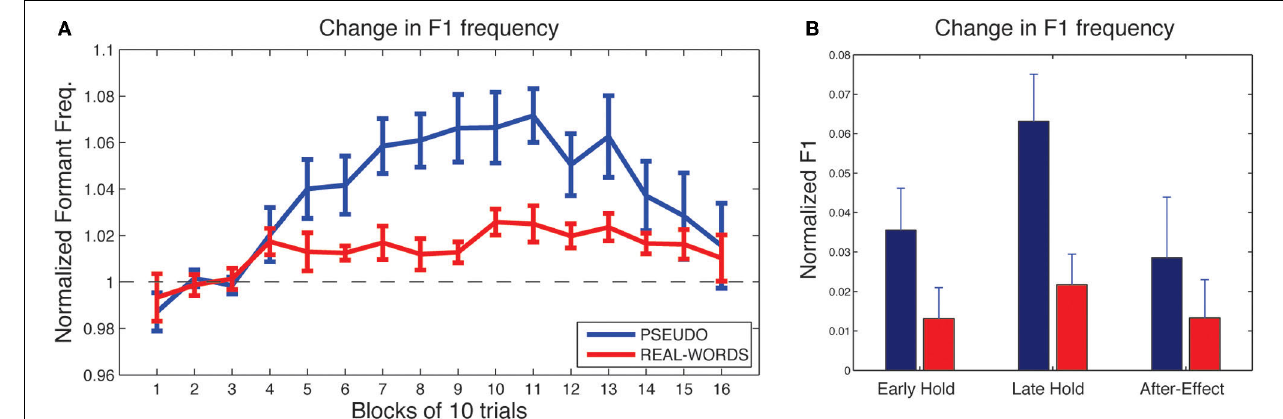
FIGURE 4 | Results of speech adaptation task for the two lexical-change groups (LC-1 and LC-2). (A) Mean F1 frequency (normalized units) is shown throughout the task, averaged over successive blocks of 10 trials each. The